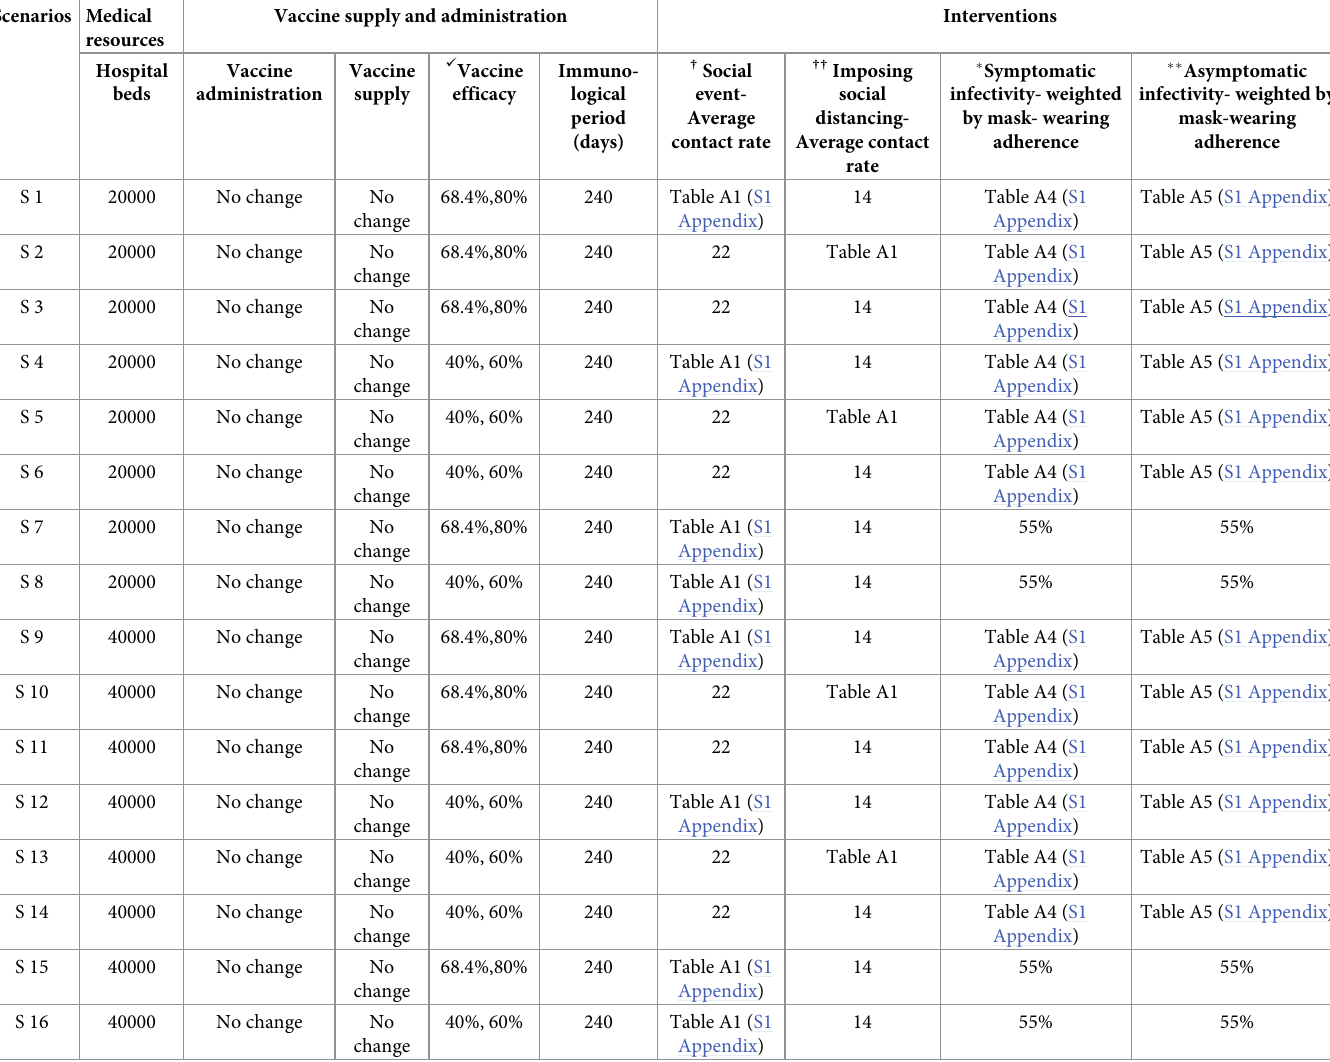
Table 2. Scenario settings in the counterfactual